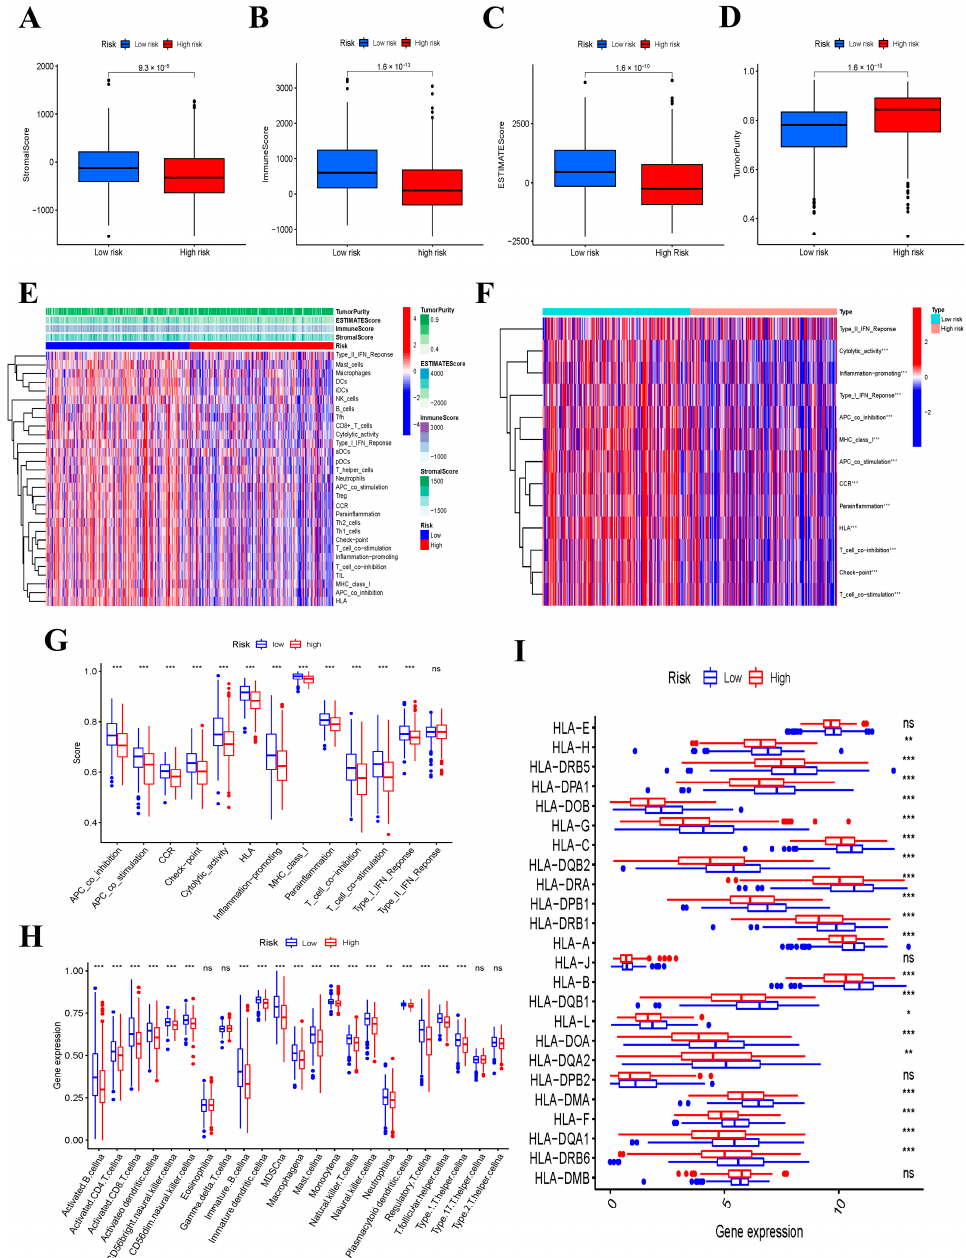
Figure 6. Comparison of the ssGSEA scores in the low − and high − risk groups. * p < 0.05; ** p < 0.01; *** p < 0.001; and ns not significant. ( A ) Stromal scores, ( B ) immune stores, ( C ) ESTIMATE scores, ( D ) tumor purity between low − and high − risk groups. ( E ) The immune status between low − and high − risk groups, ( F , G ) 13 immune − related functions, ( H ) abundance of 23 infiltrating immune cell types, and ( I ) the expression of HLA − related genes between high − and low − risk